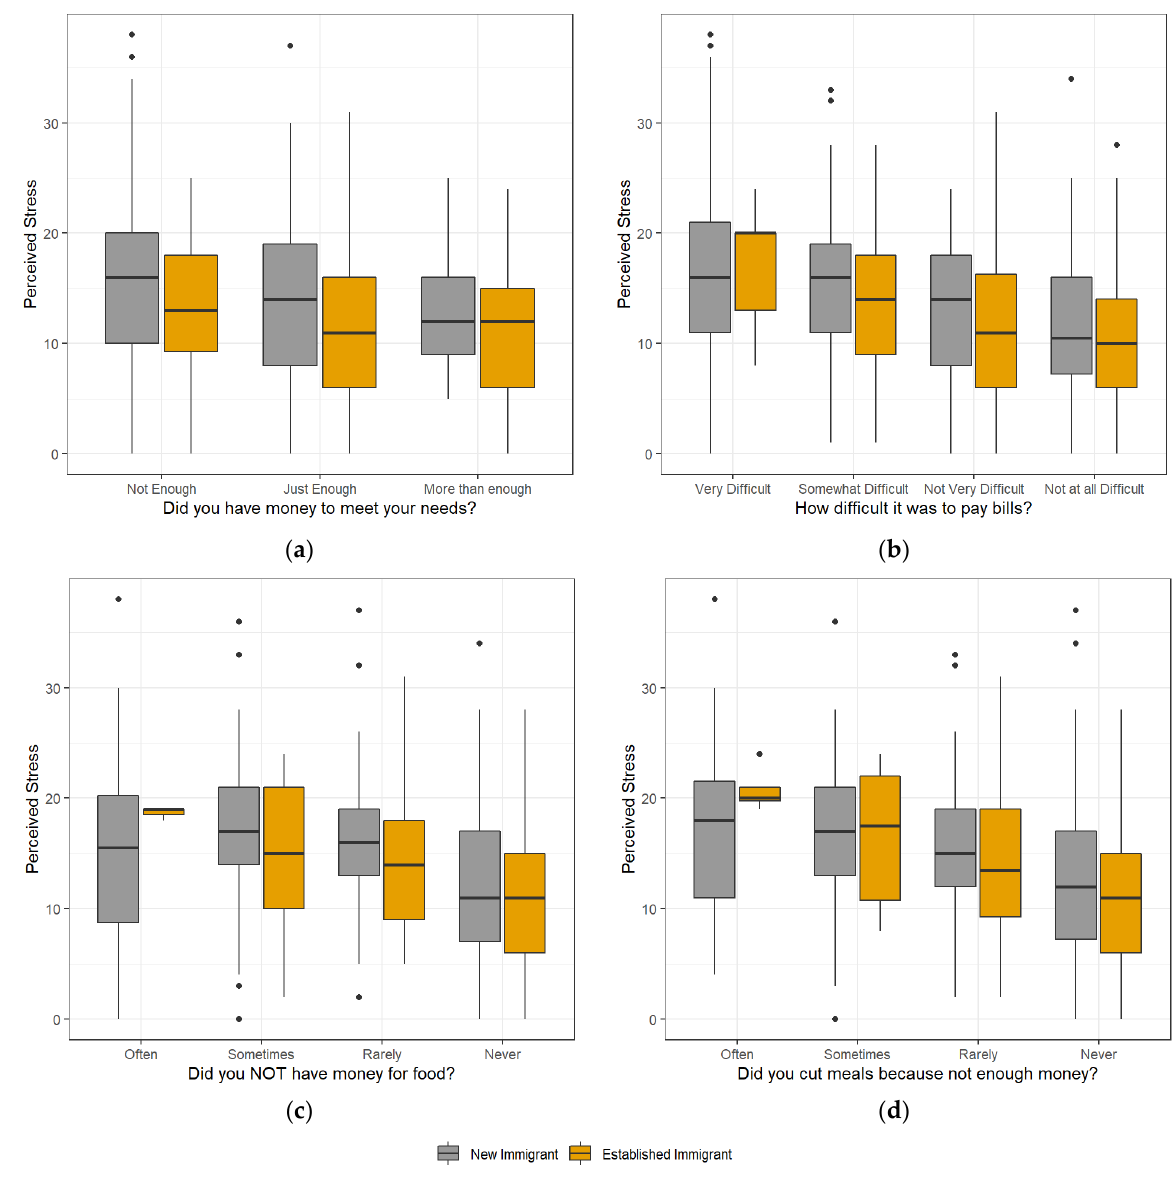
Figure 2. Boxplots for Perceived Stress in the Past Six Months across Socioeconomic Variables by Immigration Recency. Black circles are the default outliers when creating a boxplot [1.5 times the interquartile range above third quartile and below the first quartile]. ( a ) Did you have money to meet your needs? ( b ) How difficult it was to pay bills? ( c ) Did you not have money for food; ( d ) Did you cut meals because not enough